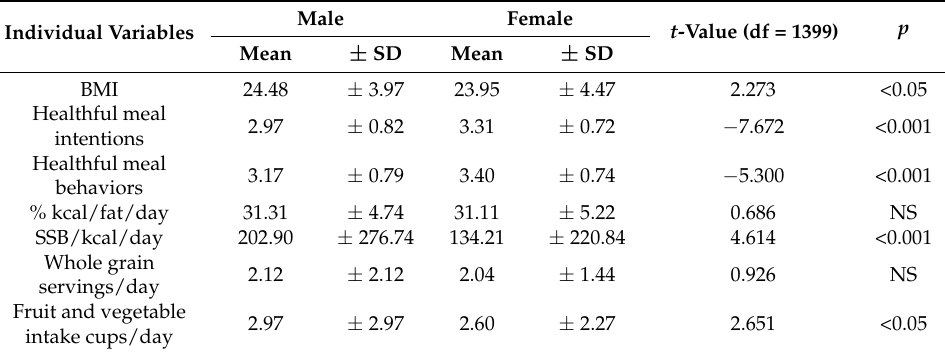
Table 3. Differences by gender for key variables ( n = 1401).